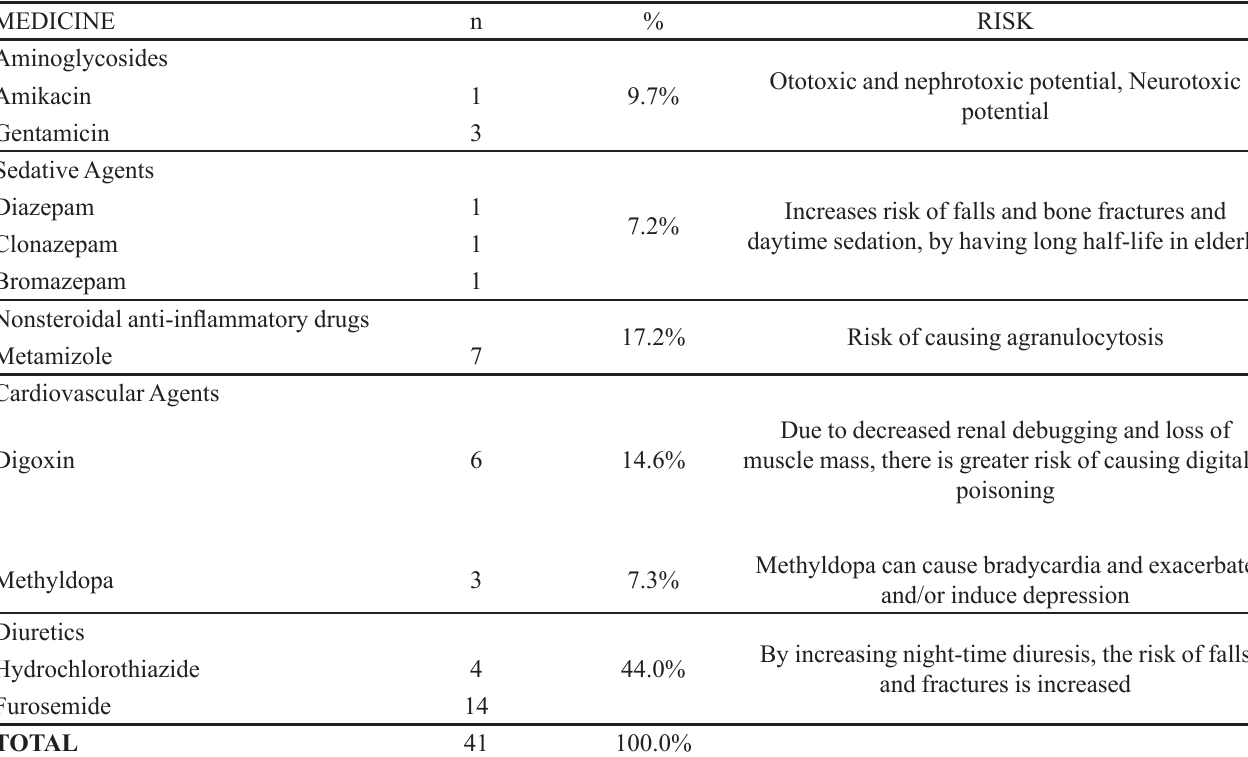
TABLE V - Medicines with potentially high risk for elderly patients